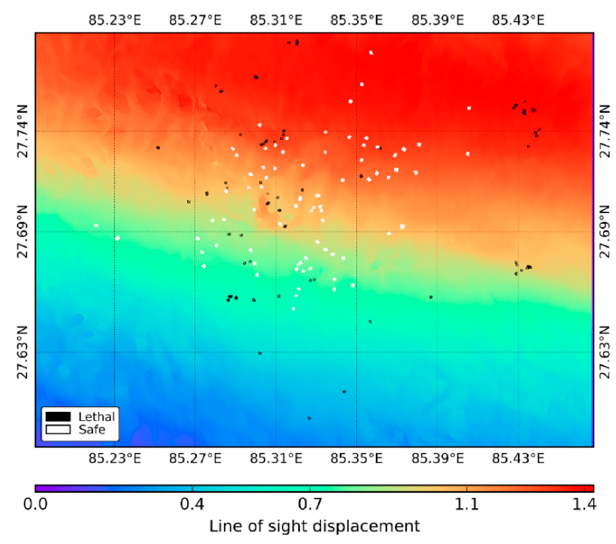
Figure 3. Distribution of the ground truth polygons in the Kathmandu Valley displayed over the line of sight displacement image resulted from differential interferometric processing in the research.